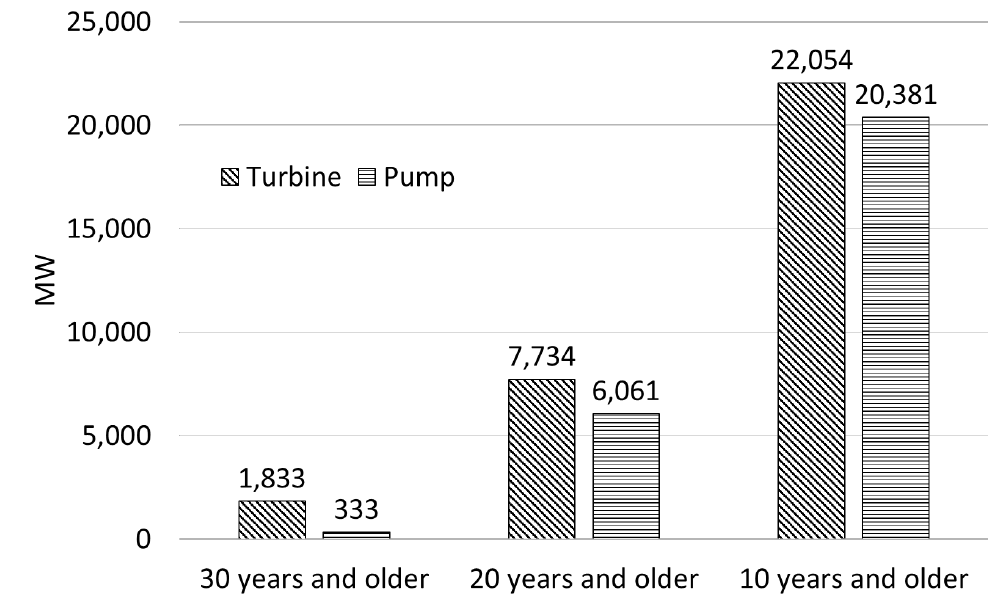
Figure 11. Cumulative capacity of PHS in China by ageing for plants commissioned until 2012.